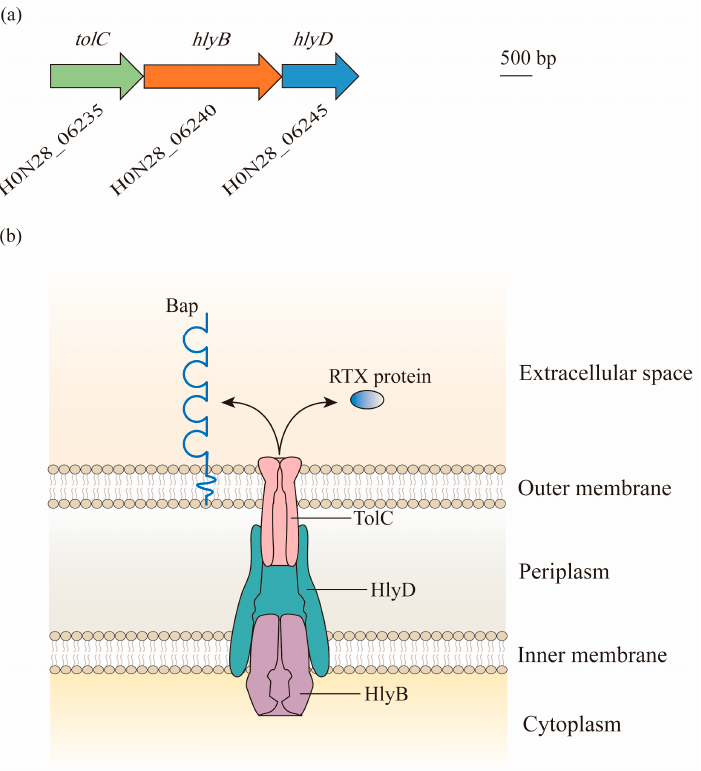
Figure 1. Composition and structure of the type I secretion system (T1SS) in A. baumannii : ( a ) Bioinformatic analysis has led to the identification of the T1SS in genomes of A. baumannii . Gene locus tags are cited from ATCC 17978. Genes predicted to encode proteins required for the biogenesis of the T1SS are found in three gene clusters, with hlyB overlapping with tolC and hlyD . ( b ) The three components of the T1SS act together to facilitate the secretion of effectors. TolC is a trimeric outer membrane protein with the α -helical barrel forming a tunnel through the periplasm, and it interacts with HlyD. HlyD has a large periplasmic domain linked by a single transmembrane helix, which anchors in the inner membrane. The energy required for the export of specific T1SS substrates is provided by HlyB, which is an ATP-binding protein. Two putative T1SS effectors, namely, Repeats-in-Toxin (RTX)-serralysin-like toxin and biofilm-associated protein (Bap), are involved in the formation and stability of biofilm.